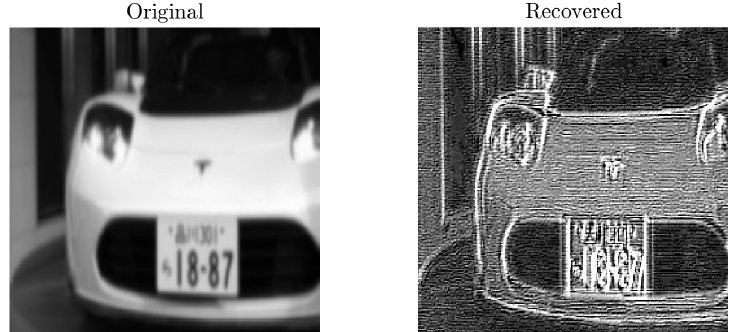
Figure 21. Further result on deblurring an image that does not belong to a training set obtained by reshuffling the dataset (namely, by modifying the order of presentation of the single images).